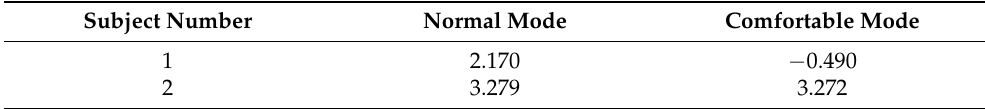
Table 2. The predicted MSL value of the subjects during the vehicle